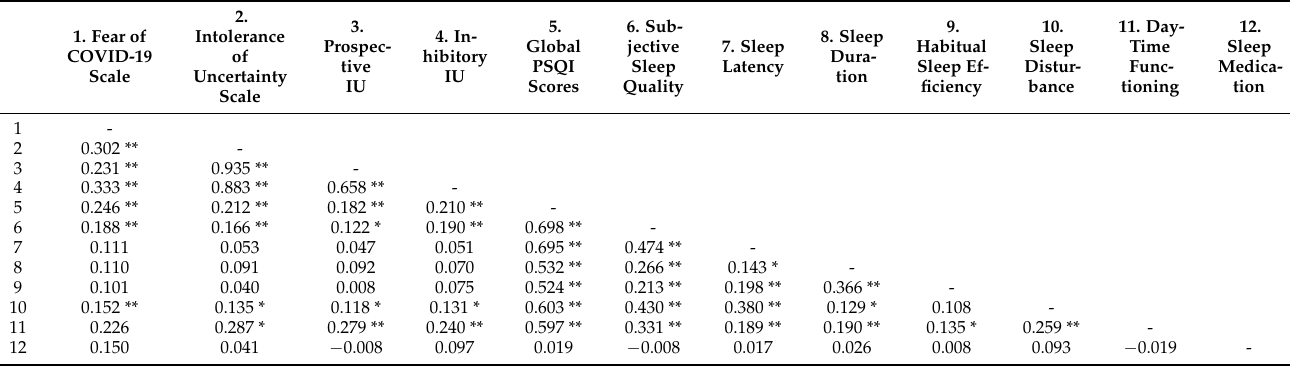
Table 4. Correlations among Fear of COVID-19, Intolerance of Uncertainty, and PSQI ( N =